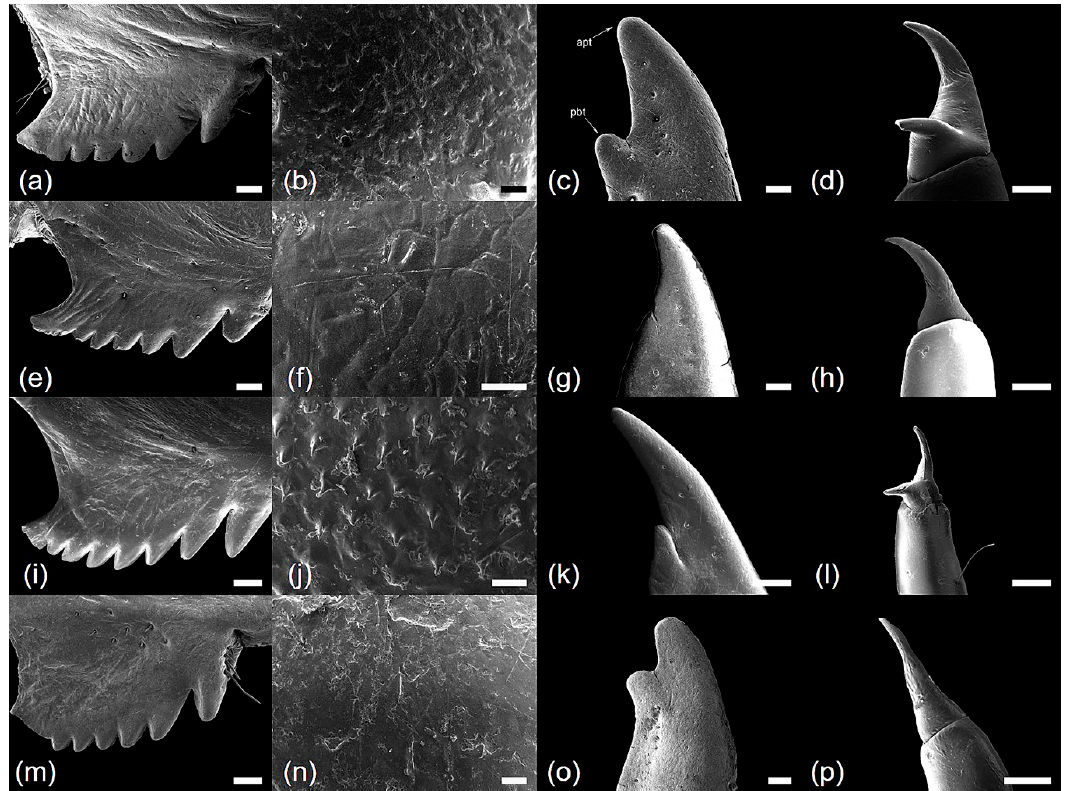
Figure 3. Scanning electron microscope micrographs of four fore-leg parts: ( a – d ) Cryptotympana atrata ; ( e – h ) Hyalessa maculaticollis ; ( i – l ) Meimuna opalifera ; ( m – p ) Platypleura kaempferi ; ( a , e , i , m ) femur comb; ( b , f , j , n ) center of femur; ( c , g , k , o ) protibia; ( d , h , l , p ) pretarsus. All scale bars = 200 μ m (except b , f , j , n , scale bars = 20 μ m).